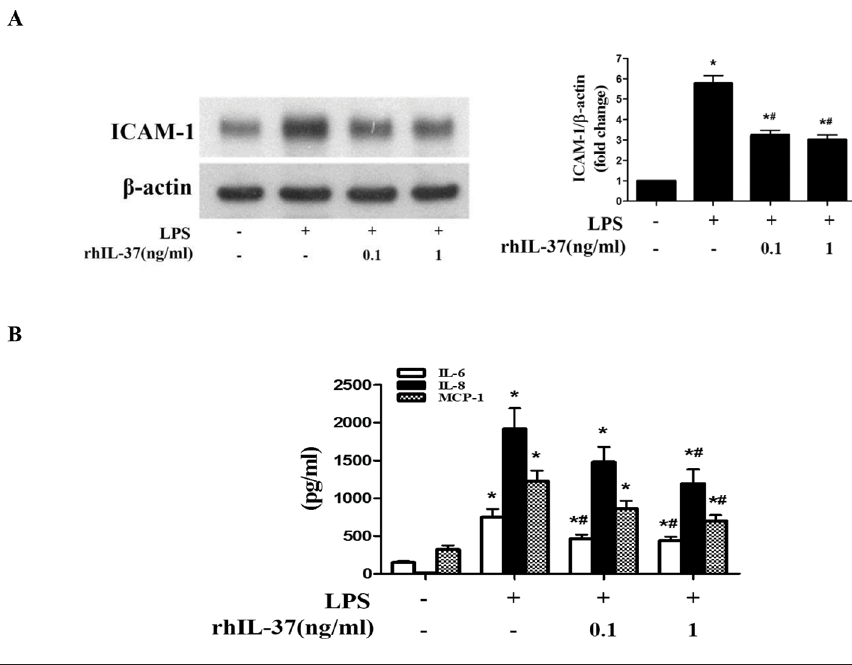
Figure 1. IL-37 attenuates the inflammatory responses induced by TLR4 stimulation in human AVICs. AVICs were treated with lipopolysaccharide (LPS, 0.2 μ g/mL) for 24 h in the presence and absence of recombinant IL-37 (0.1 and 1.0 ng/mL). (A) Representative im- munoblots and densitometric data show that IL-37 reduced ICAM-1 production induced by LPS. (B) Cytokine data show that IL-37 suppressed production of IL-6, IL-8 and MCP-1 following stimulation with LPS, and the higher concentration of IL-37 had a greater effect. Data are mean ± SE. n = 6 experiments using cell isolates from distinct donor valves; * P <0.05 versus untreated control; # P <0.05 versus LPS